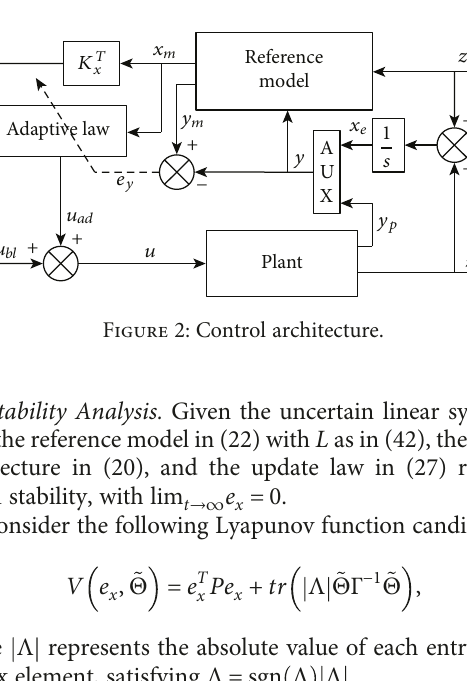
Figure 3: The nominal case tracking